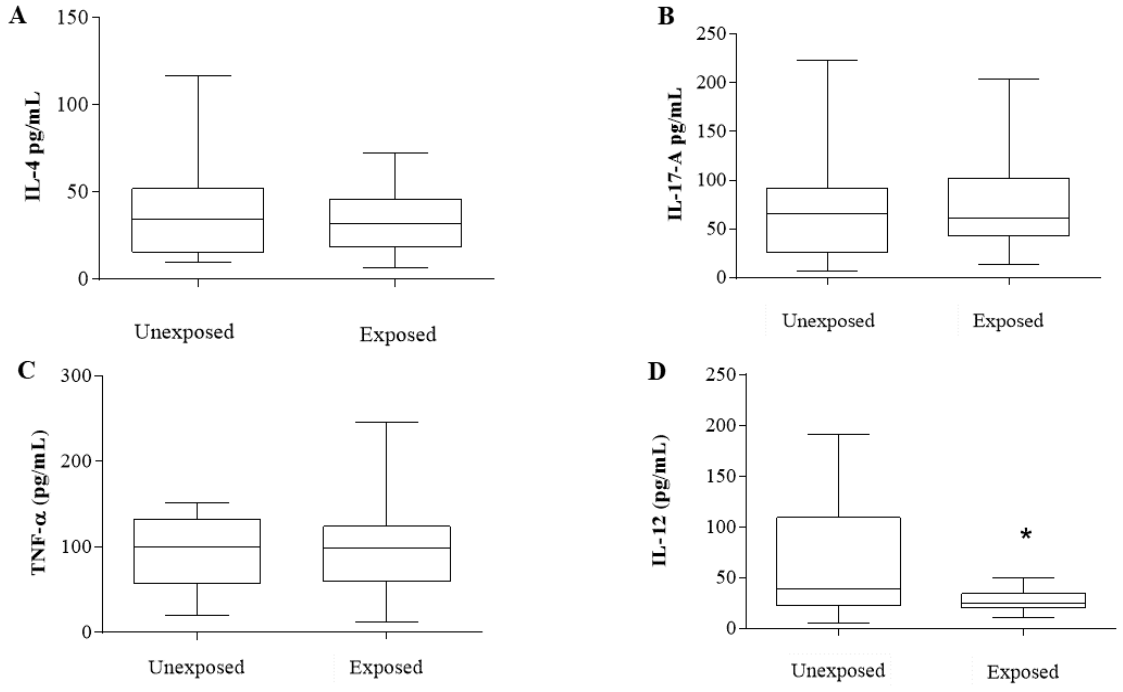
Figure 3. Cytokine profile of exposed and unexposed breast cancer patients from intermediate-risk stratification. ( A ) Interleukin 4. ( B ) Interleukin 17-A. ( C ) TNF- α. ( D ) Interleukin 12. All measured in pg/mL. Results are represented in box plots (min–max). * Indicates statistically significant difference ( p < 0.05). Analyses were performed with GraphPad Prism 7.0 Software (San Diego, CA, USA).